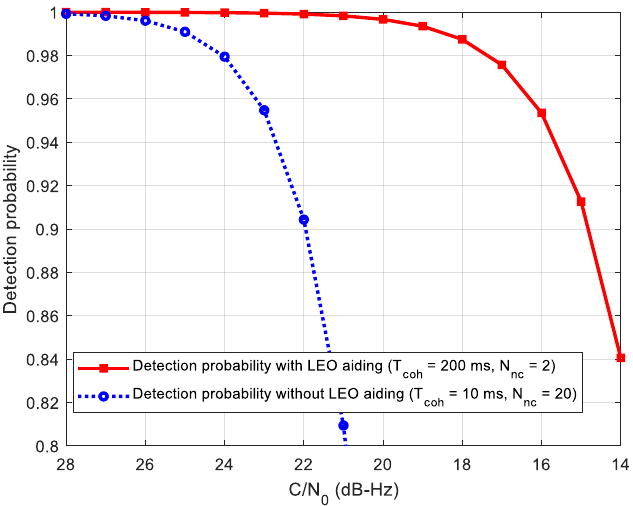
Figure 11. Acquisition performance under different carrier-to-noise ratio (C/N 0 ).